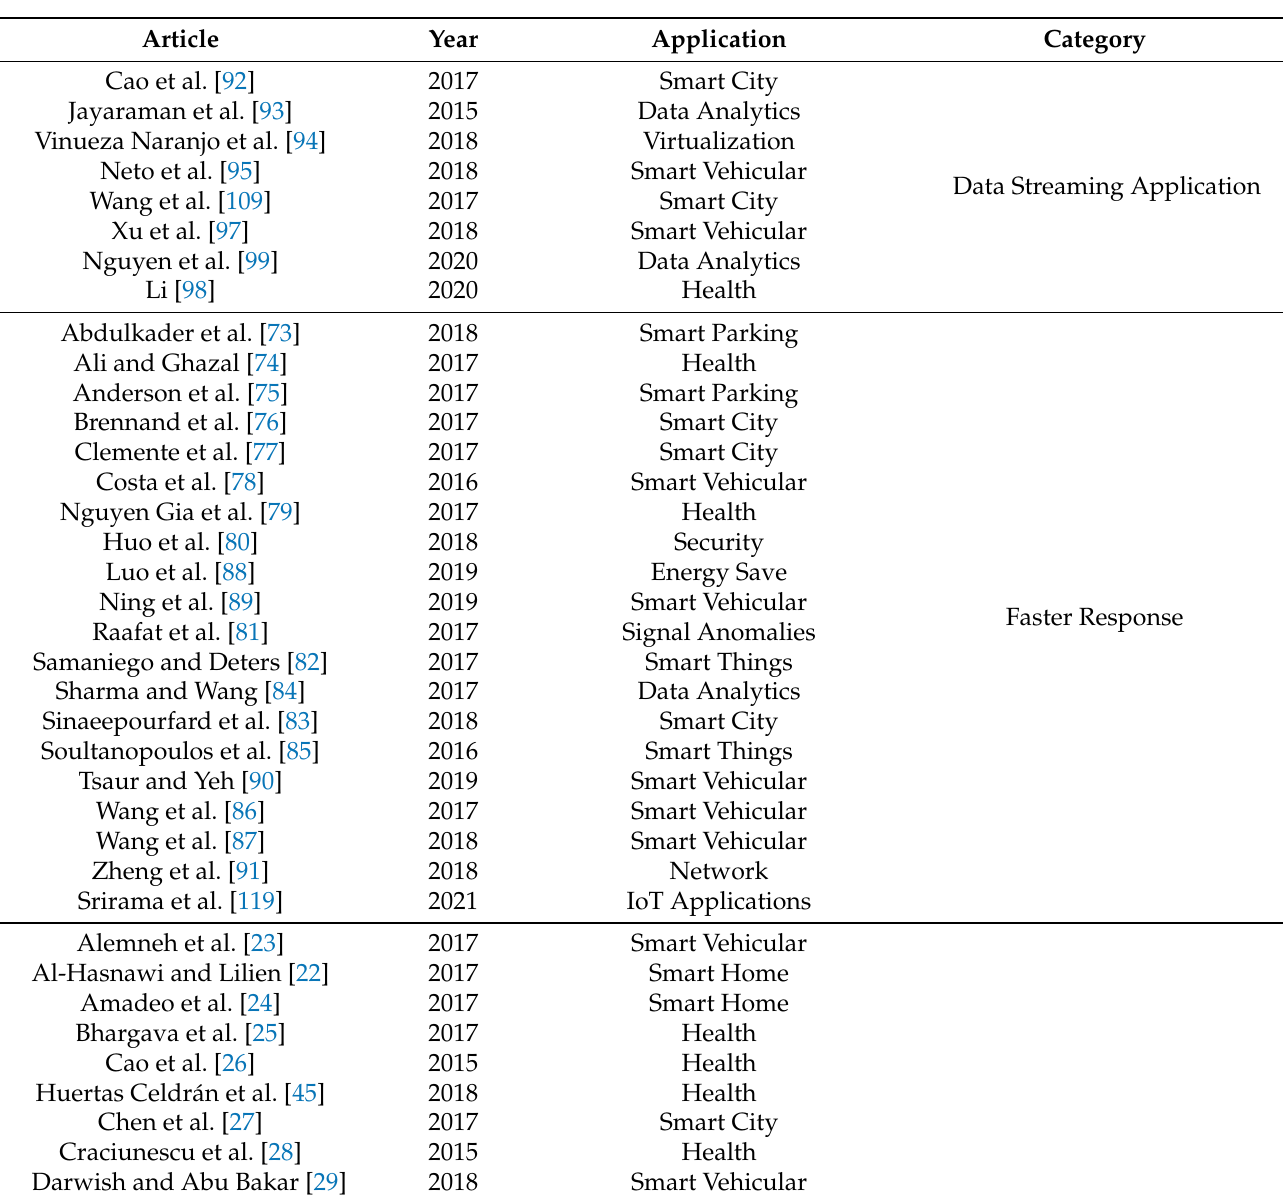
Table 4. List of selected